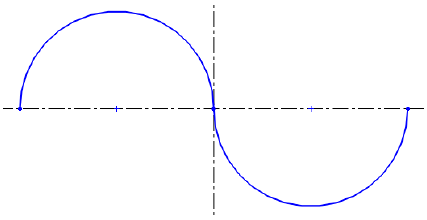
Figure 6. Two continuous semicircles. Radius: 1.